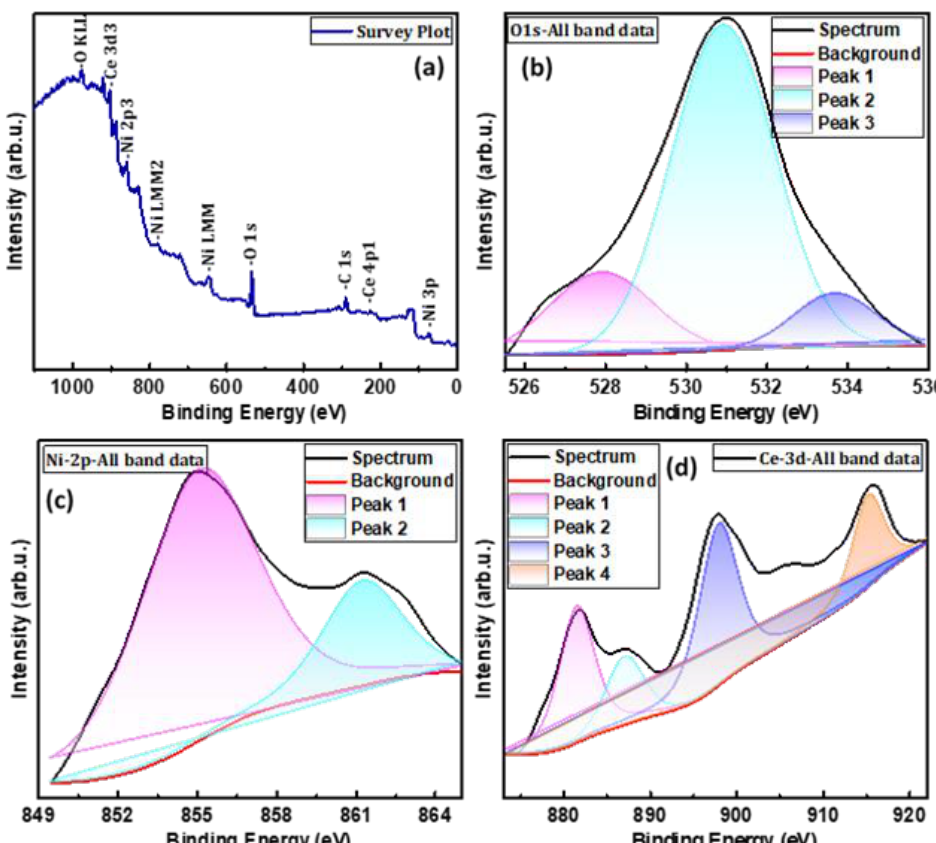
Figure 8. ( a ) Survey spectrum of CeO 2 /NiO nanocomposite, XPS spectra of ( b ) O1s, ( c ) Ni2p, and ( d ) Ce3d.